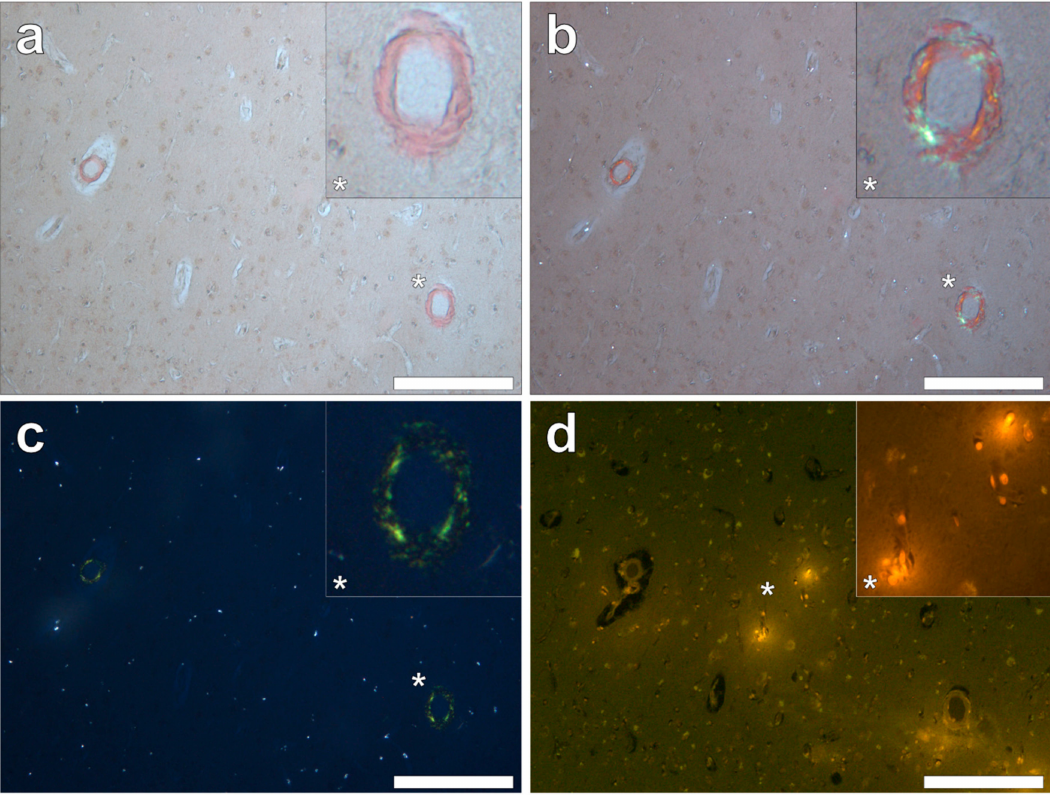
Figure 9. Congo red reactive amyloid deposited independently of lumogallion-reactive aluminium in the temporal lobe. Positive Congo red staining was observed under bright field ( a ), partial ( b ) and fully ( c ) polarised light, demonstrating an apple-green birefringence confirming the presence of amyloid with a β -pleated sheet conformation. Intracellular aluminium identified in glial-like cells ( d ) was not co-located with amyloid within the vasculature. Magnified inserts are denoted by asterisks. Magnification 100 × ; scale bars 200 µ m.